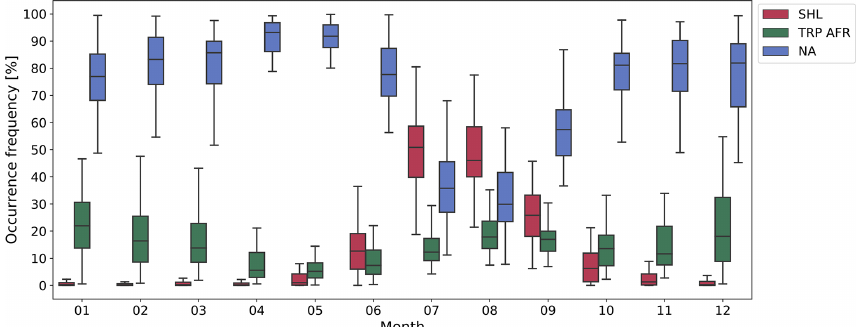
Figure 14. Monthly climatology of the occurrence frequency of air parcels originating from the convective boundary layer of the Saharan heat low and from the free troposphere above the Saharan heat low (SHL, red boxplots), air parcels coming from tropical Africa (TRP AFR, green boxplots), and air parcels originating from the North Atlantic (NA, blue boxplots). The classification is based on backward trajectories started every 6h and from every 20hPa between 500 and 700hPa above Tenerife using ERA-Interim data from 1979–2018. The boxplots show the interquartile range by the extent of the box and the median by the black line in the box. The whiskers correspond to 1.5 times the proportion of the interquartile range past the lower and upper